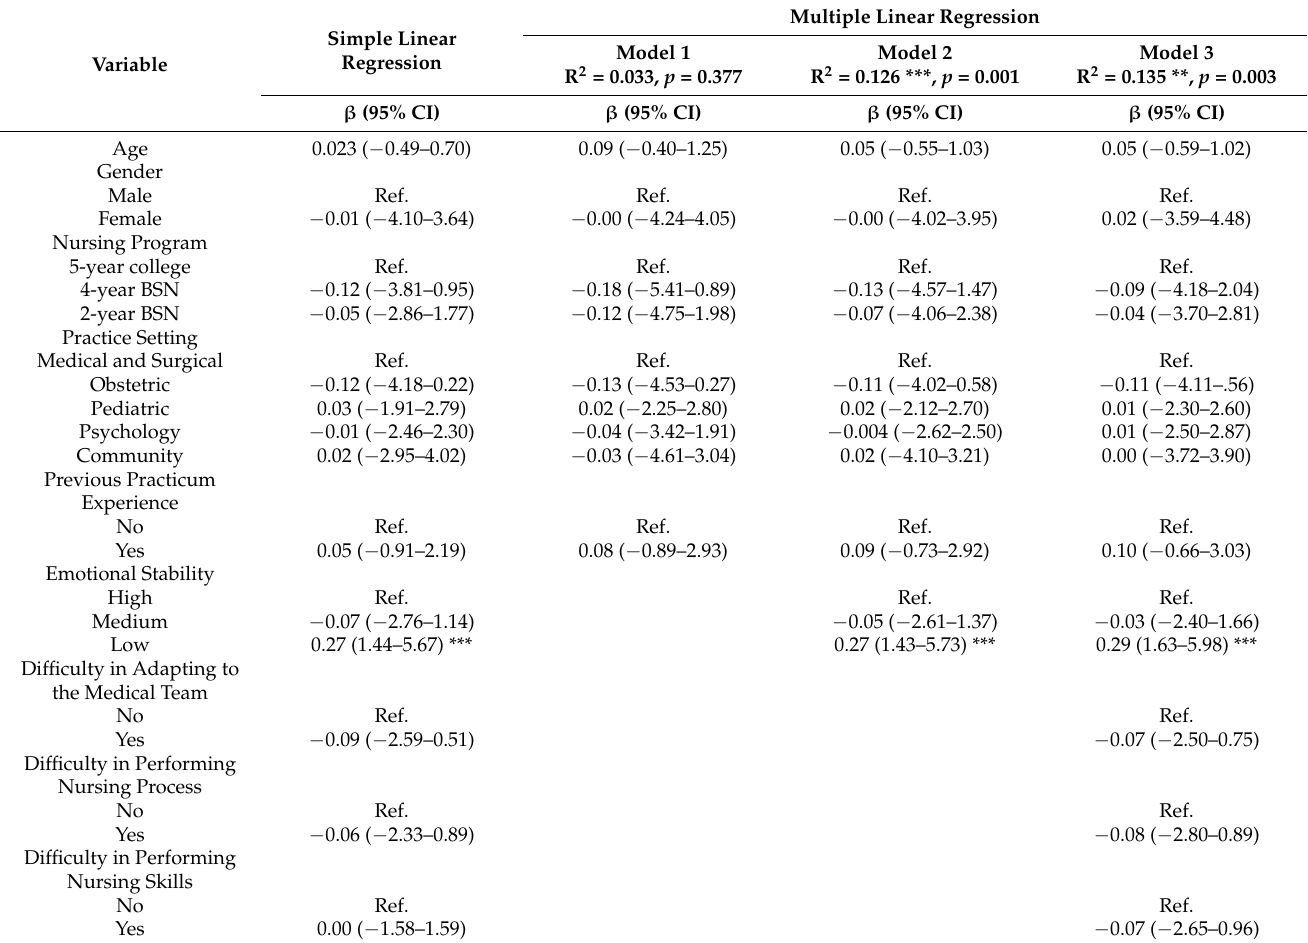
Table 2. Comparison of the predictors of the professional performance of the participants ( n =